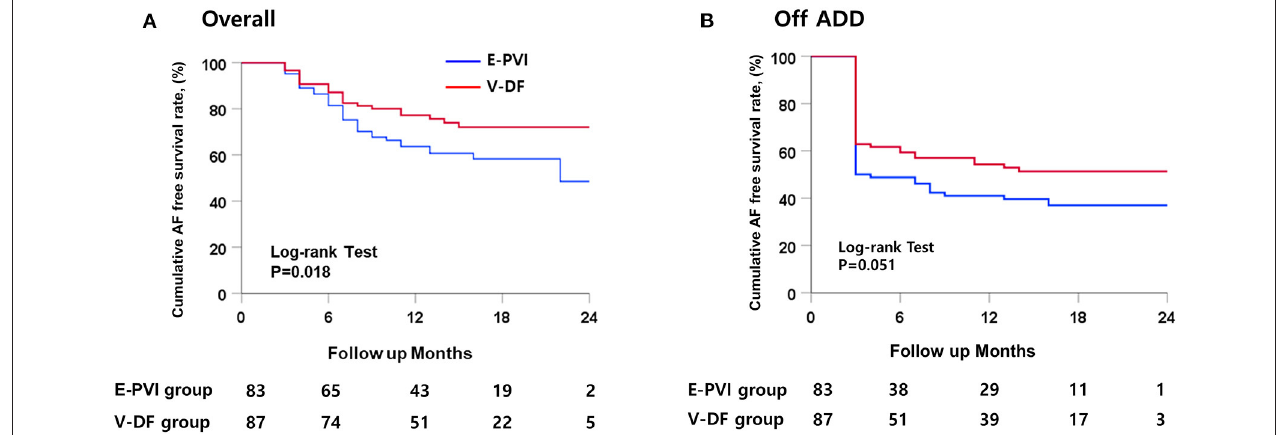
FIGURE 4 | Kaplan–Meier curves for the cumulative AF-free survival. (A) Overall patients. (B) Patients maintaining AAD use after catheter ablation.